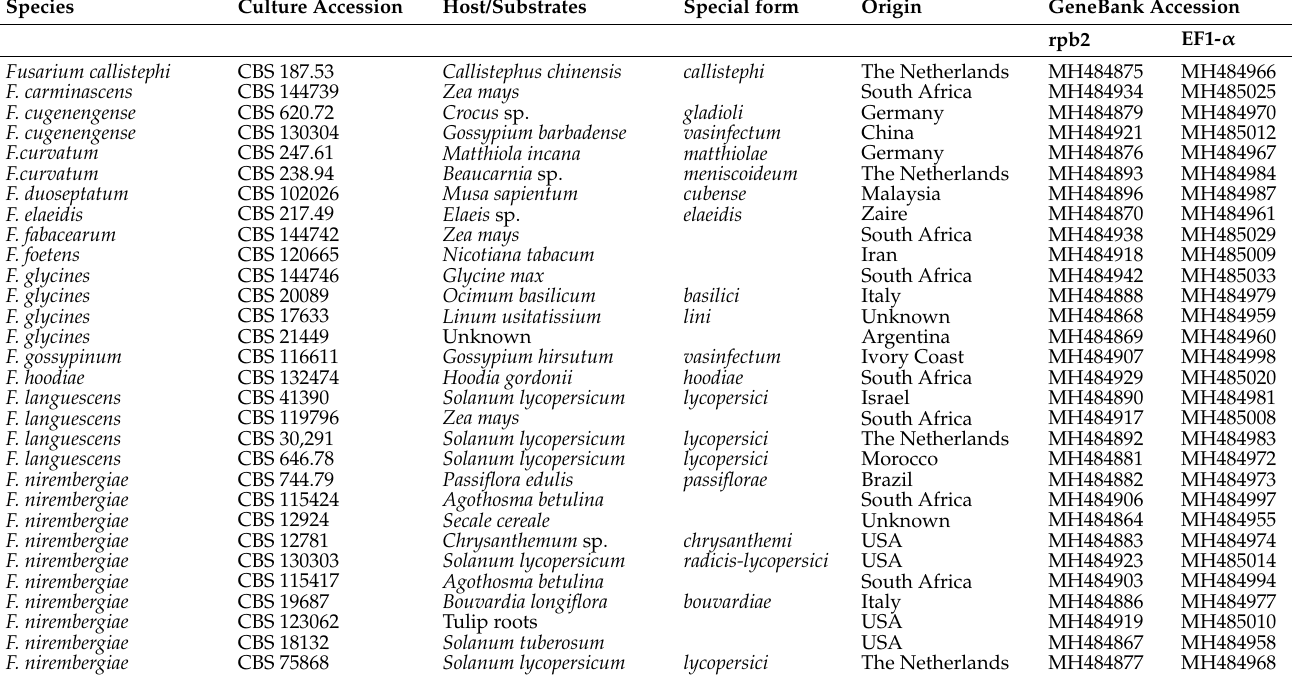
Table 1. Characteristics of Fusarium isolates included in the phylogenetic